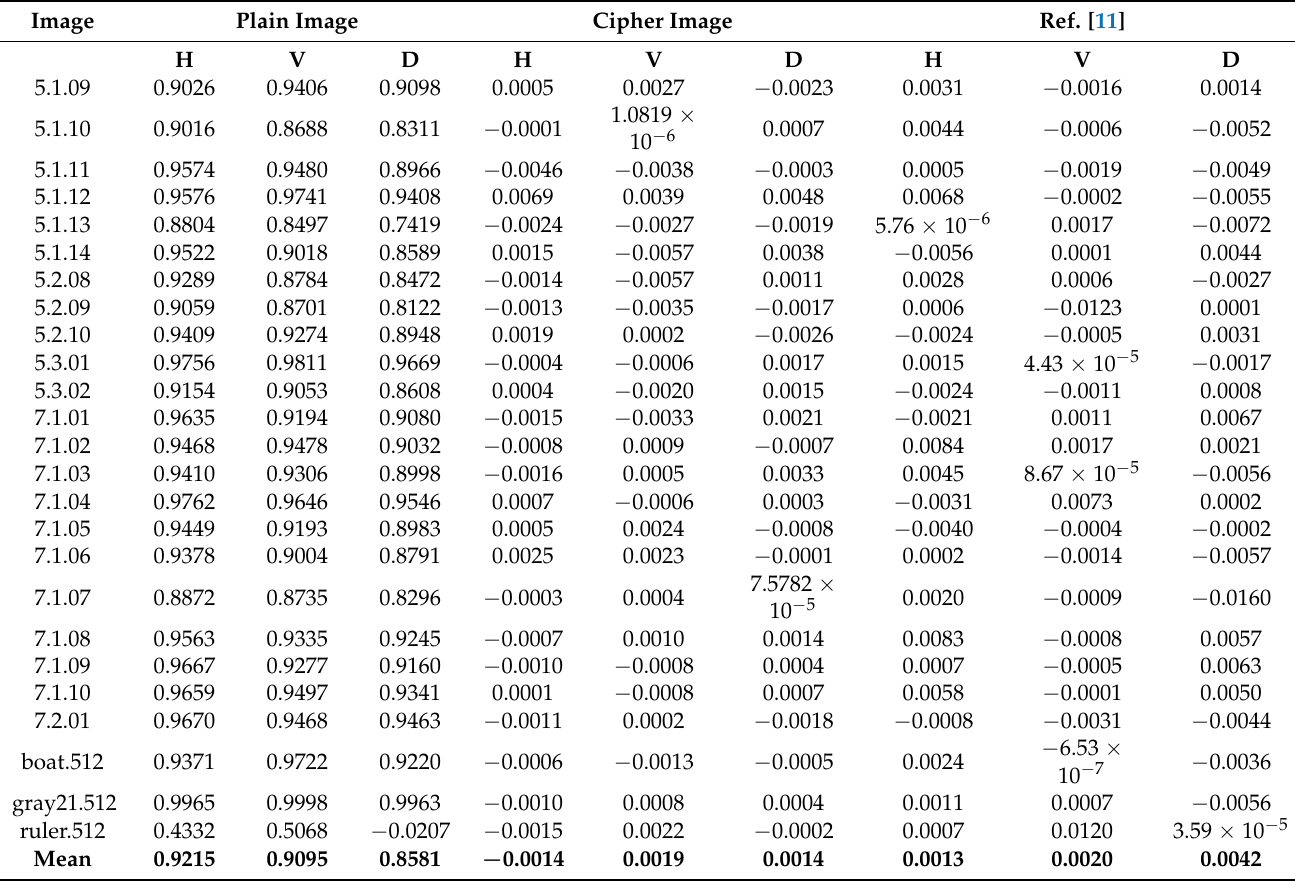
Table 3. Pixel correlation in different